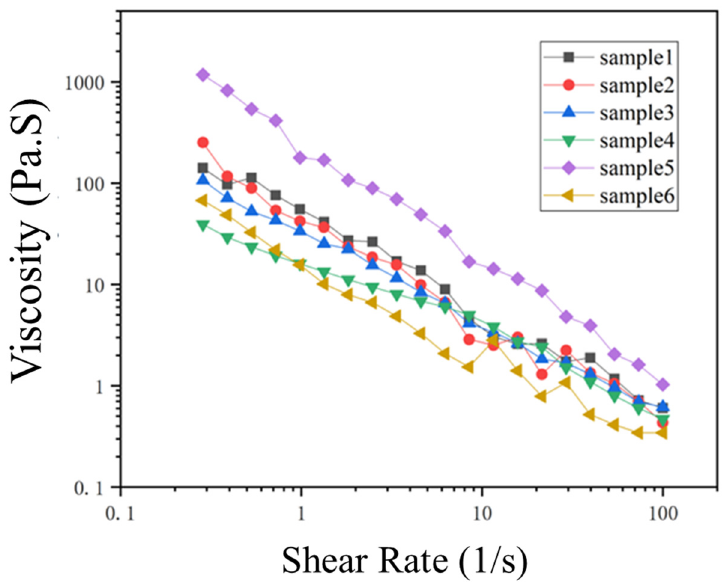
Figure 5. Rheological properties of microbial oils A. protothecoides (AP) and C. sorokiniana (CS); thraustochytrids S. limacinum (SL) and Aurantiochytrium sp. T66 (AT); and yeasts R. toruloides (RT) and C. curvatus (CC) obtained in this study. Log–log plot of viscosity as a function of shear rate is a figure. Schemes follow the same formatting.